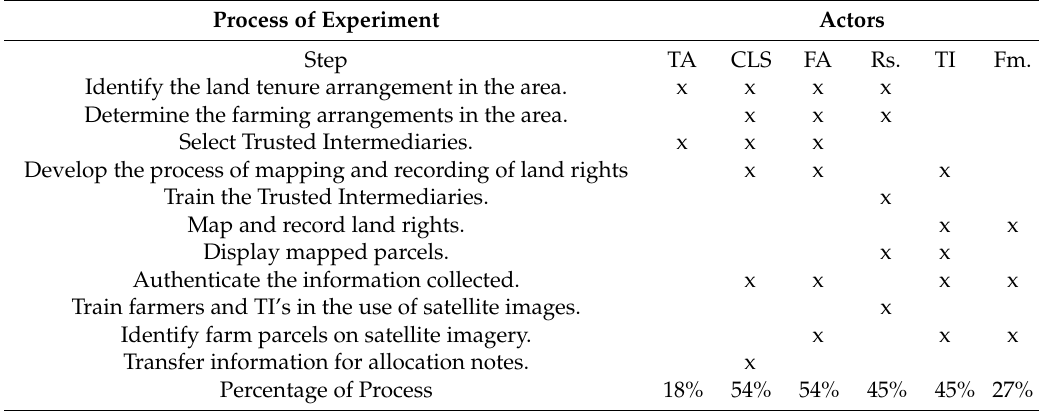
Table 4. The Experiment Process and the Role of the Actors. Process of Experiment